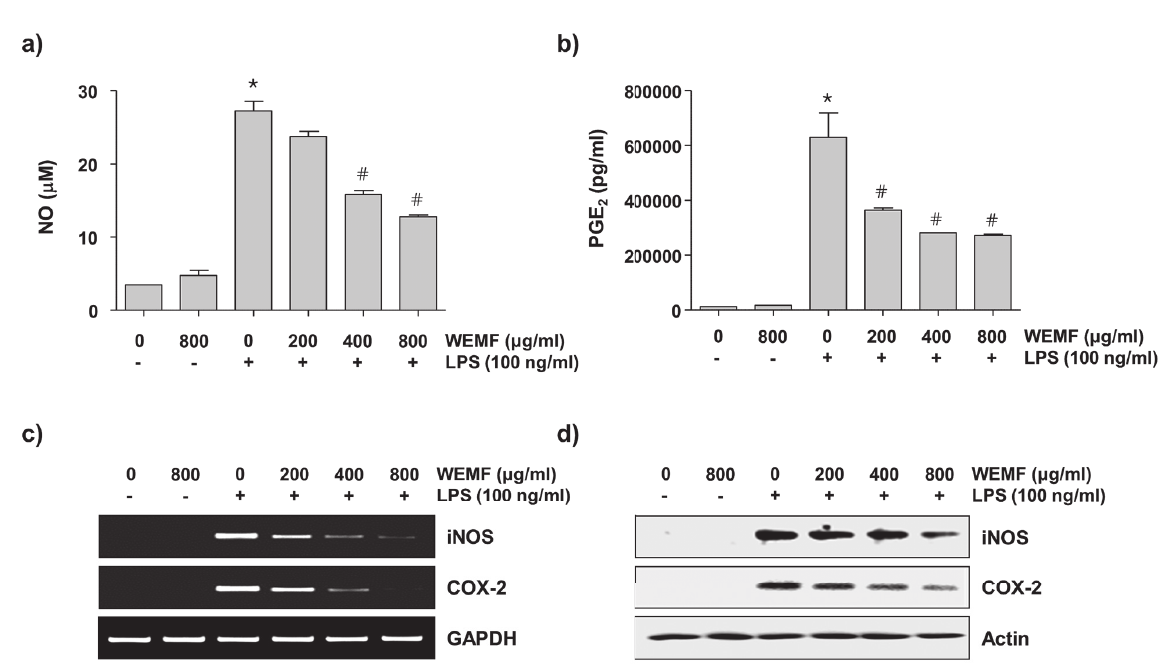
production by WEMF in LPS-stimulated RAW 264.7 macrophages. The cells were pretreated Figure 3 - Inhibition of NO and PGE 2 with the indicated concentrations of WEMF for 1 h prior to incubation with 100 ng/ml LPS for 24 h. The levels of NO (a) and PGE (b) in culture media were measured by Griess assay and a commercial ELISA kit, respectively. Each value indicates the mean ± SD and is representative of the results obtained from three independent experiments ( # p<0.05 compared with the control; *p<0.05 compared with cells cultured with 100 ng/ml LPS). (c) The total RNAs were isolated from cells grown under the same conditions as those in Figure 3 and prepared for the RT-PCR analysis of the iNOS and COX-2 mRNA expression using the indicated primers. (d) Cell lysates were prepared for Western blot analysis, with antibodies specifi c for murine iNOS and COX-2, and for an ECL detection system. The experiment was repeated three times and similar results were obtained. GAPDH and actin were used as the internal controls for the RT-PCR and Western blot analysis, respectively. WEMF BLOCKS LPS-INDUCED NF-κB NUCLEAAR TRANSLOCATION IN RAW 264.7